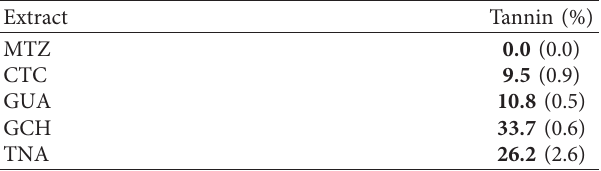
Values within the parenthesis are standard